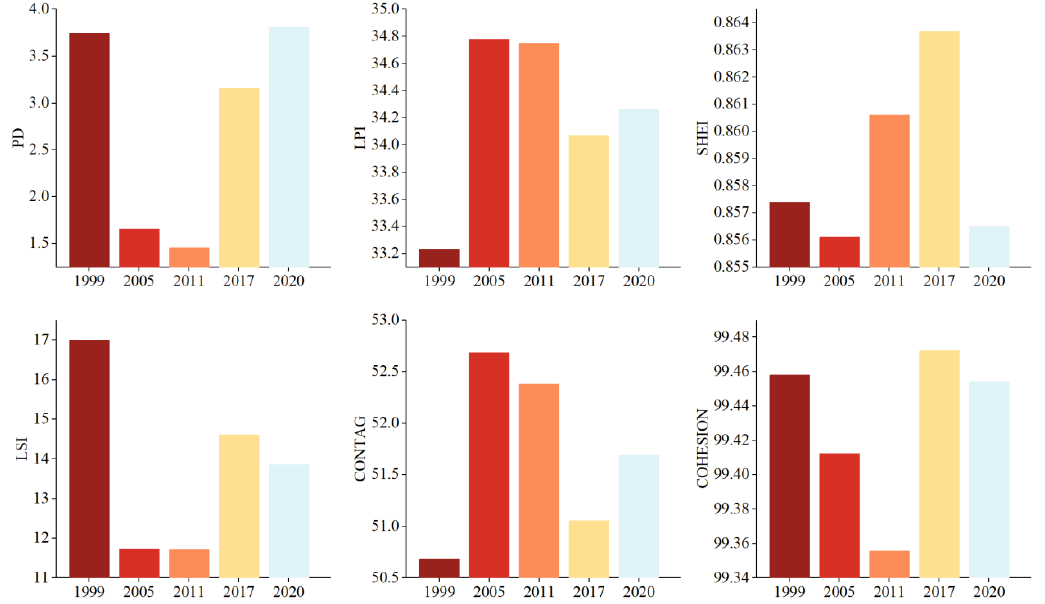
Figure 10. Changes in the wetland landscape index from 1999 to 2020.